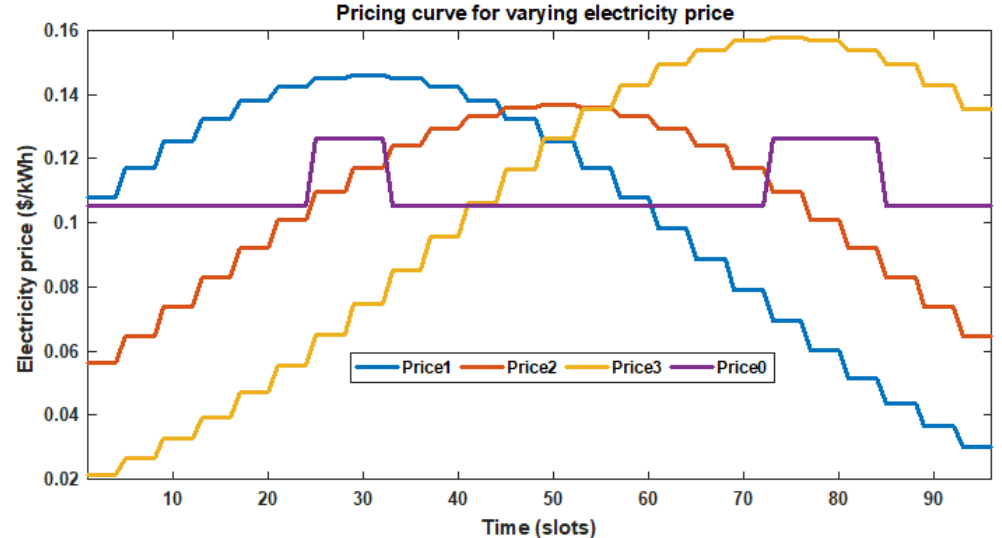
Figure 10. Daily profile for the various electricity pricing schemes.